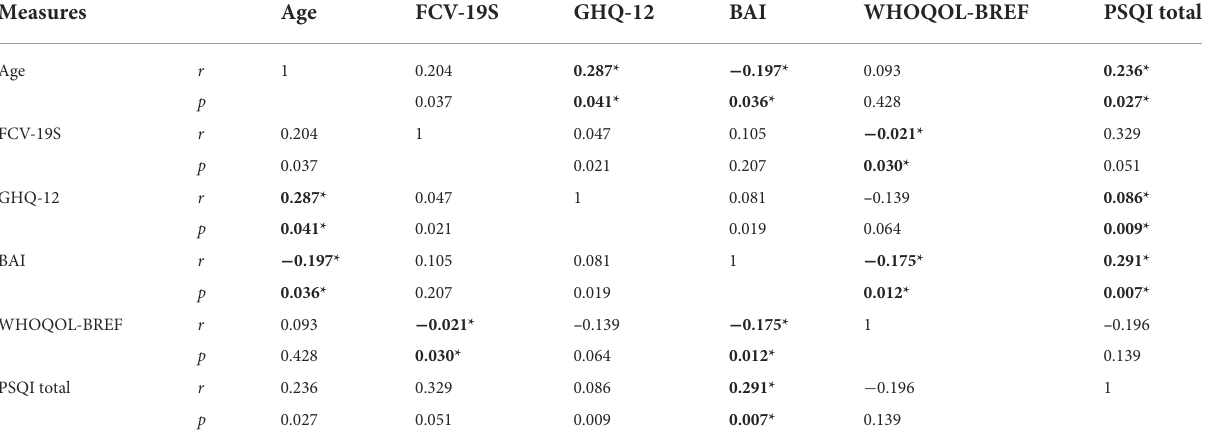
TABLE 6 Correlation analysis between our suggested measures (the studied European countries).